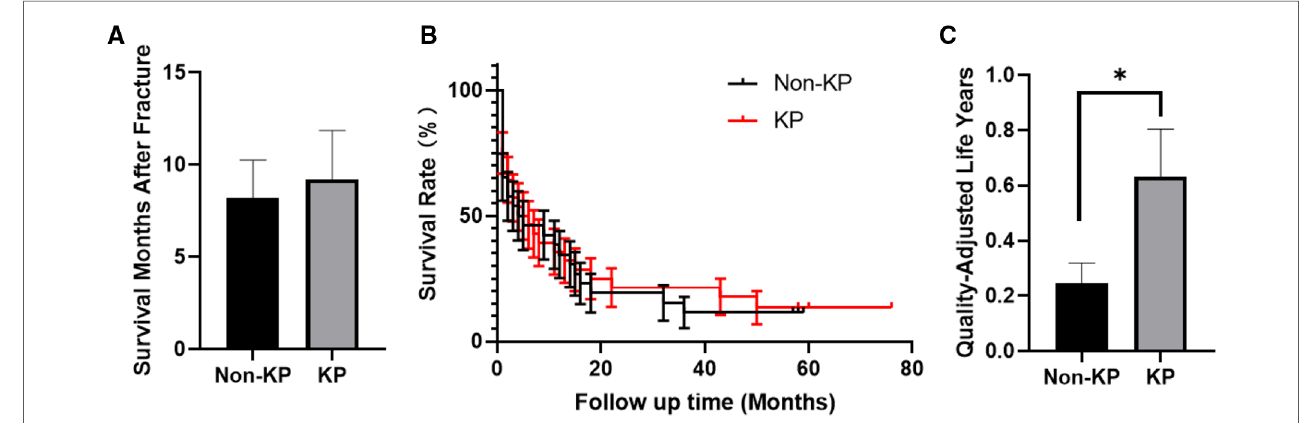
FIGURE 5 ( A ) Survival months of the patients after fracture. ( B ) Survival curve of the patients. ( C ) Quality-adjusted life years of the patients ( *p